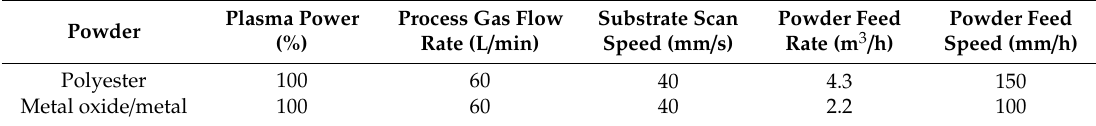
Table 1. Coating Parameters for polyester, metal oxide and metal